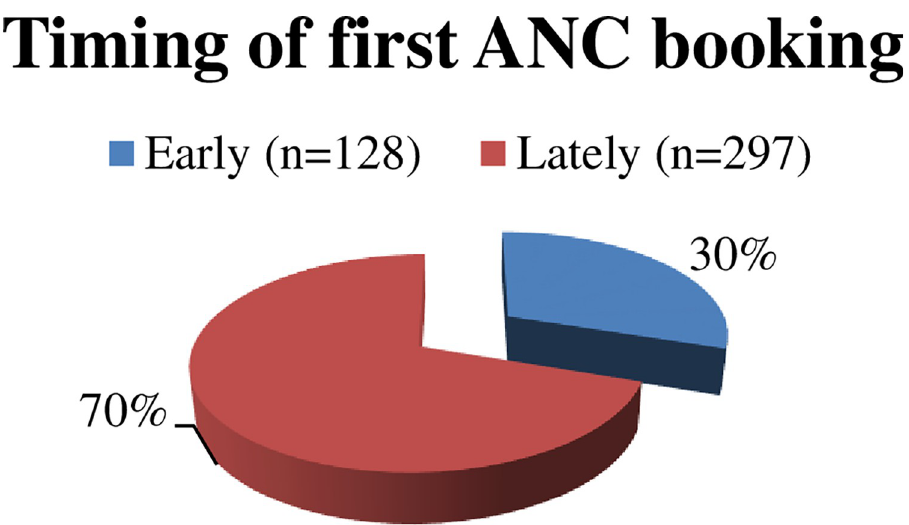
Fig 2. Timing of first Antenatal care booking among pregnant women in Mizan-Aman town, southwest, Ethiopia, 2021.